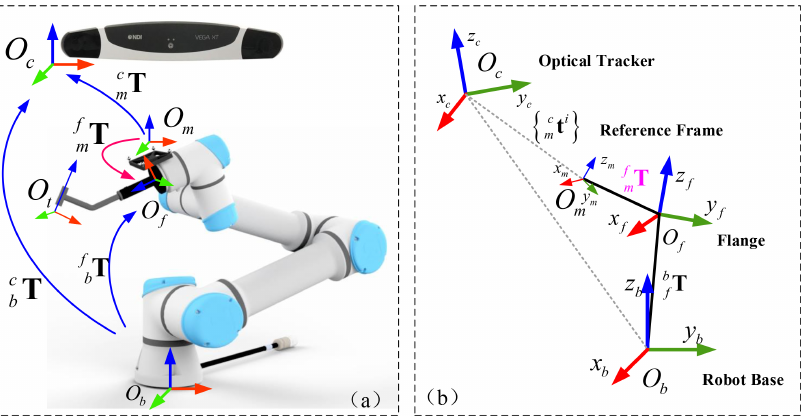
Figure 3. A schematic illustration of spatial transformations involved in the hand-eye calibration. ( a ) the set up; ( b ) the coordinate